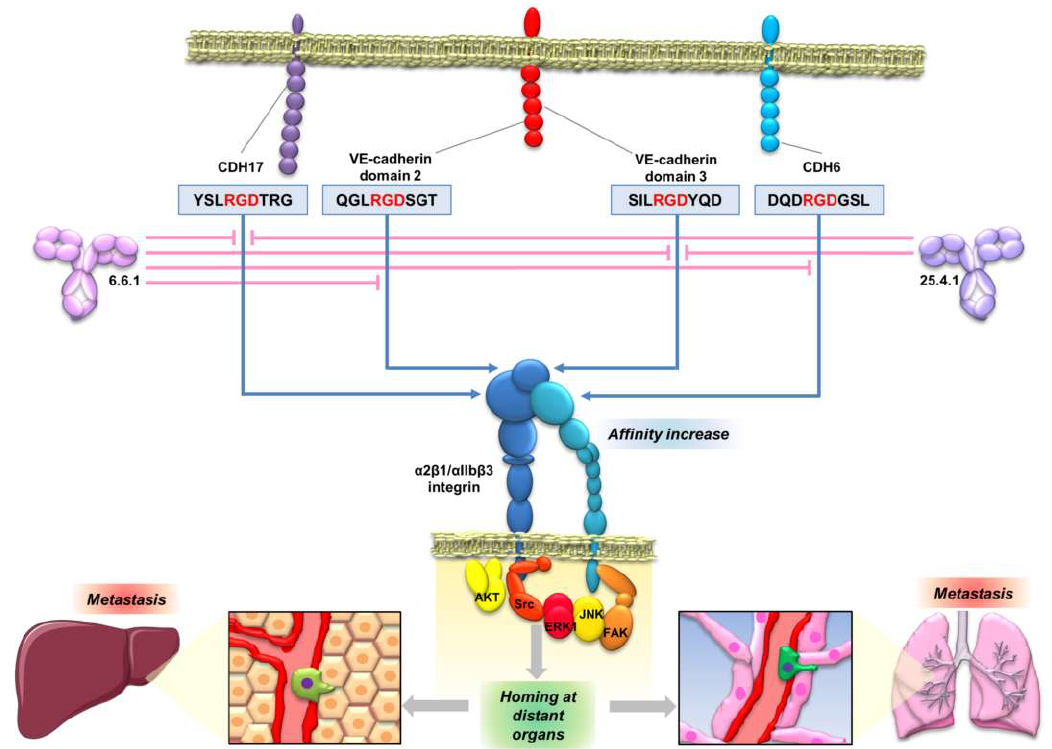
Figure 5. Anti-cadherin RGD antibodies as a potential therapeutic strategy against metastasis. Schematic representation of the activity of two anti-cadherin RGD monoclonal antibodies, showing their specificities against RGD motifs in cadherins. The antibodies can inhibit the interaction of the RGD motifs with the integrins, blocking their activation, signaling and consequently, the metastatic behavior of cancer